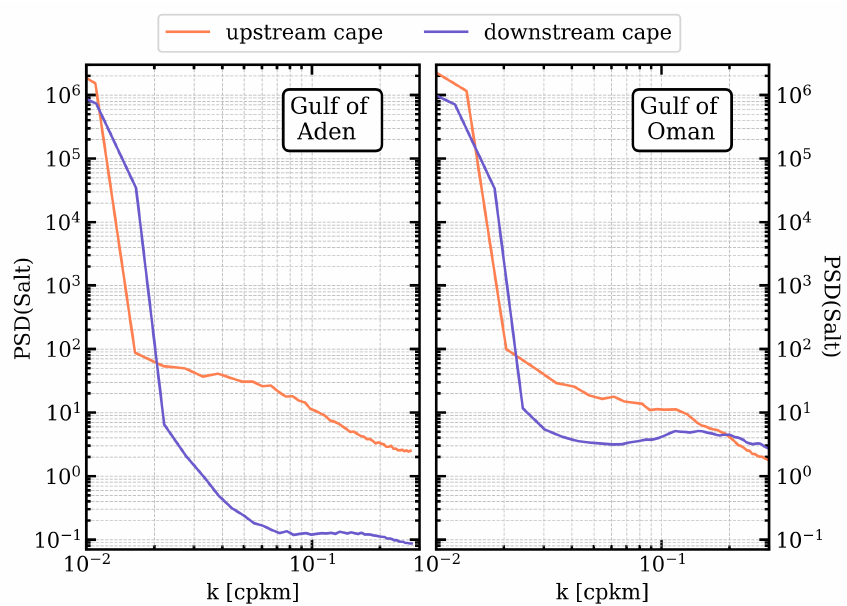
Figure 12. Power Spectral Densities of salinity ( left ) in the Gulf of Aden and ( right ) in the Gulf of Oman, (orange) upstream and (blue) downstream of the